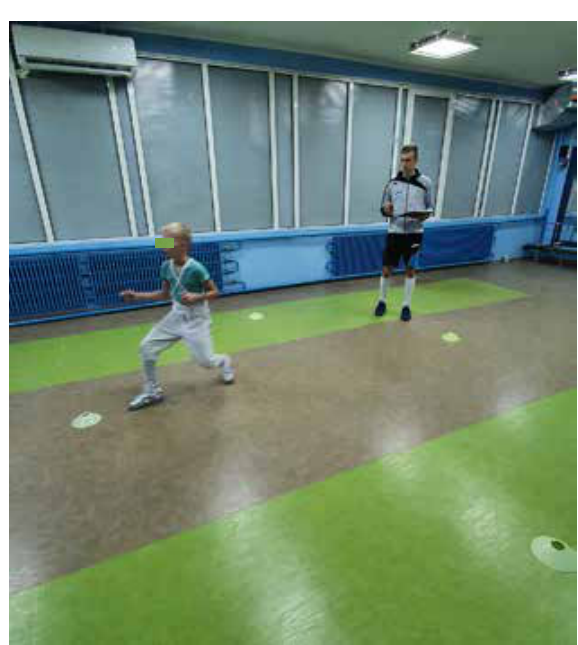
Figure 1. Test “Hits into the target, 30 sec. points” (photo - Irina Kriventsova)